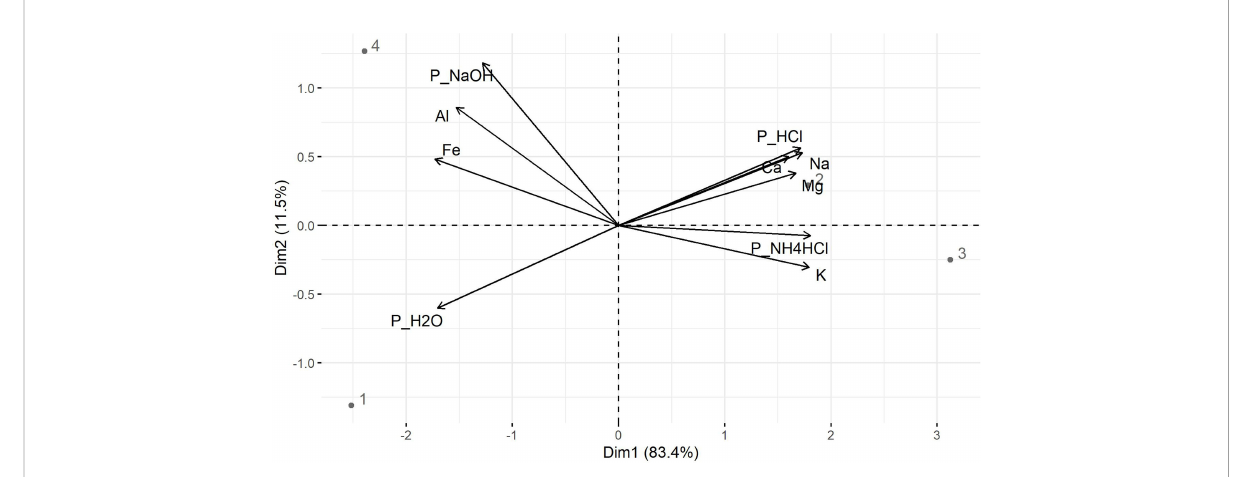
FIGURE 2 Biplot of component 1 (Dim1) and 2 (Dim2) of the Principle Component Analyses (PCA) for P soluble in water (P H2O ), 1 M NH 4 Cl at pH 7 (P NH4Cl ), 0.1 M NaOH (P